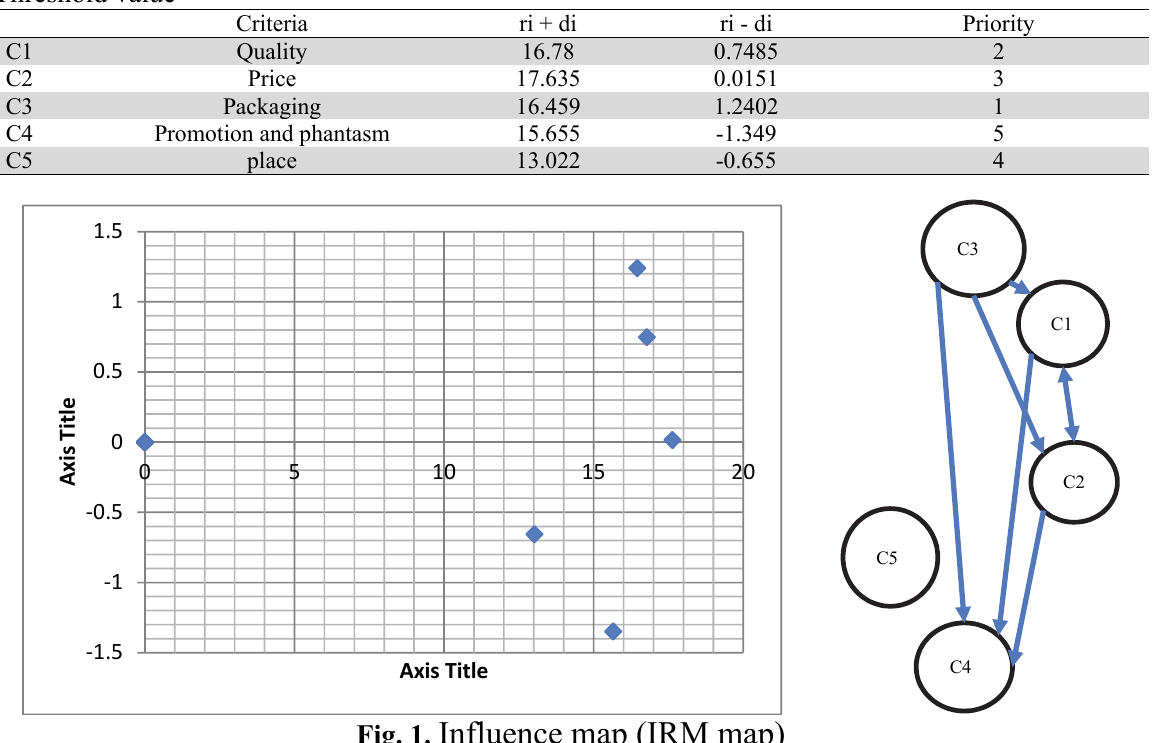
Fig. 1. Influence map (IRM